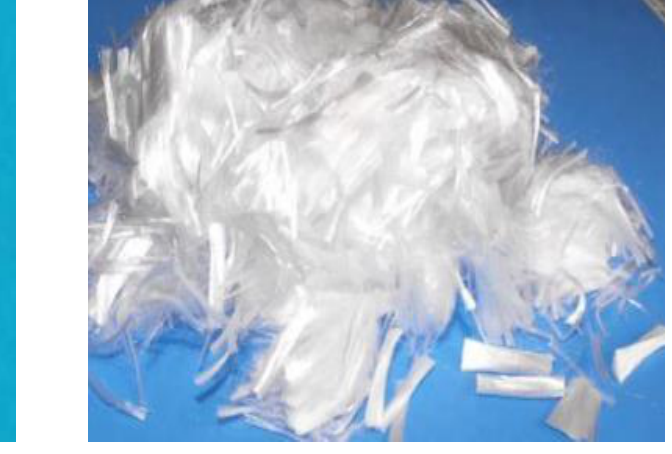
Figure 1. ( a ) Gradation curve of fine aggregate, ( b ) gradation curve of peach shell and coarse aggregate.